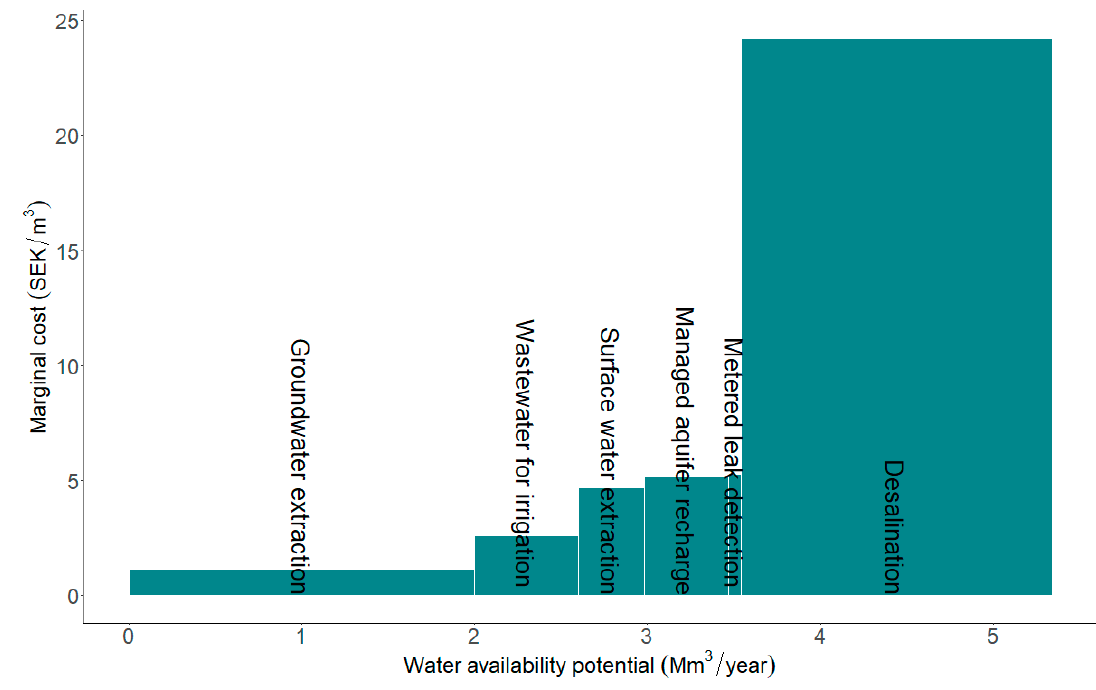
Figure 4. Marginal abatement cost curve for alternative measures to improve water resource security on the island of Gotland (100 SEK ≈ 11 USD).